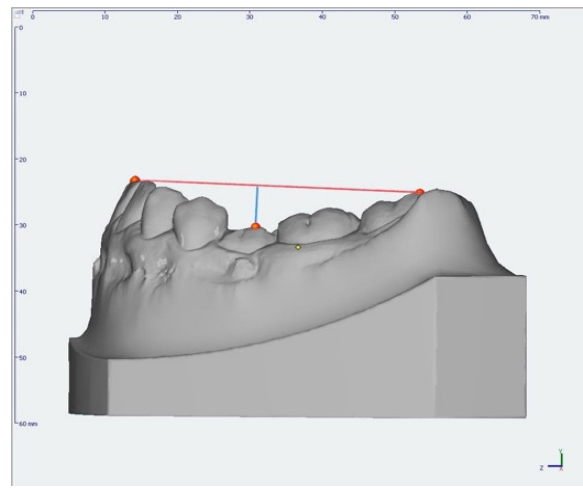
Figure 1. Digital measurement of the Curve of Spee in a dental arch with a persisting primary second molar.